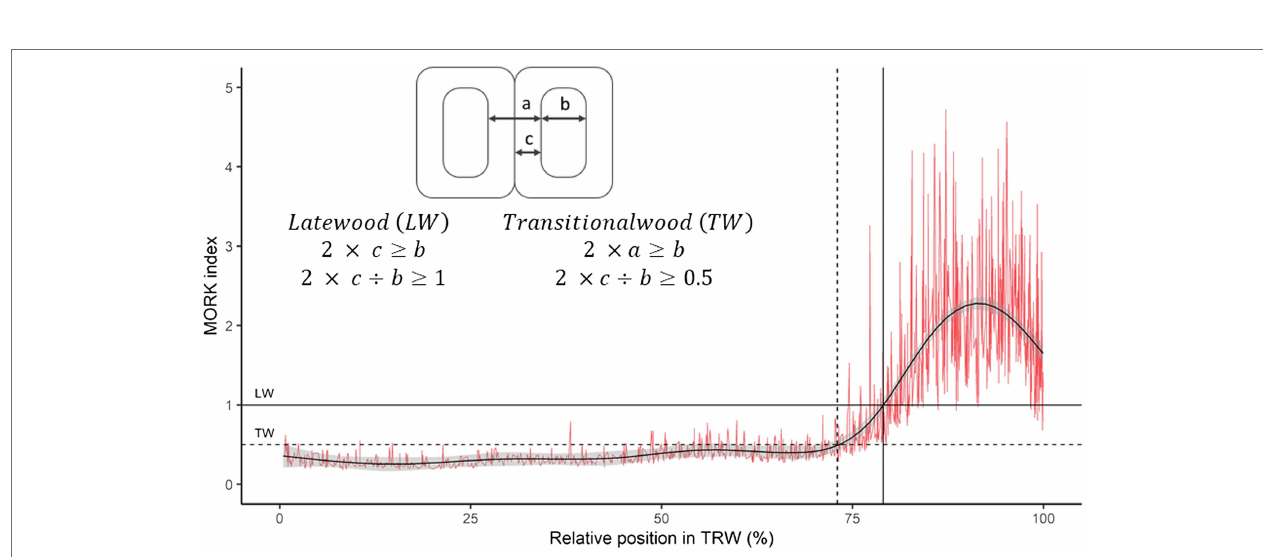
FIGURE 1 | Sampling and analysis of quantitative wood anatomy. (A) Increment cores were collected with a 5 mm increment borer while the resistance measurements were performed with a Resistograph R650-SC 3–4 cm above the increment borer sampling point. (B) Measurements of tree-ring widths (TRW) and wood-anatomical features (vessel area—VA, tracheid area—TA, radial and tangential diameter of vessels and tracheids—DRAD and DTAN, radial tracheid wall thickness—CWTRAD, and tangential tracheid wall thickness—CWTTAN in spruce).